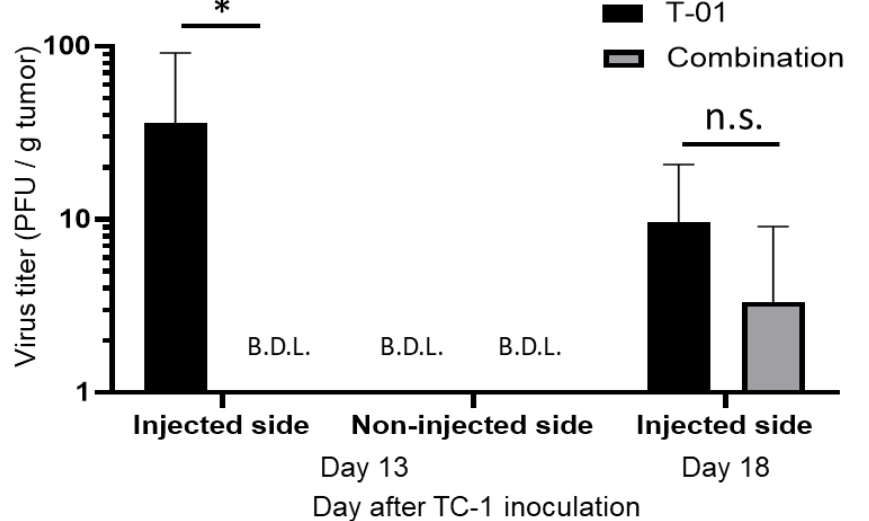
Figure 4. Analysis of viral titers in TC-1 tumor. Thirteen and eighteen days after tumor implanta- tion, quantification of T-01 in the tumors of the T-01 and combination groups was performed. Day 13 is 2 days after the second virus administration and 2 days after the anti-PD-L1 antibody admin- istration. Day 18 is 2 days after the third virus administration and 7 days after the anti-PD-L1 anti- body administration. These results are presented as the mean + SD ( n = 3 per group). The Mann – Whitney test was used to determine statistical significance (* p < 0.05, n.s.: not significant).